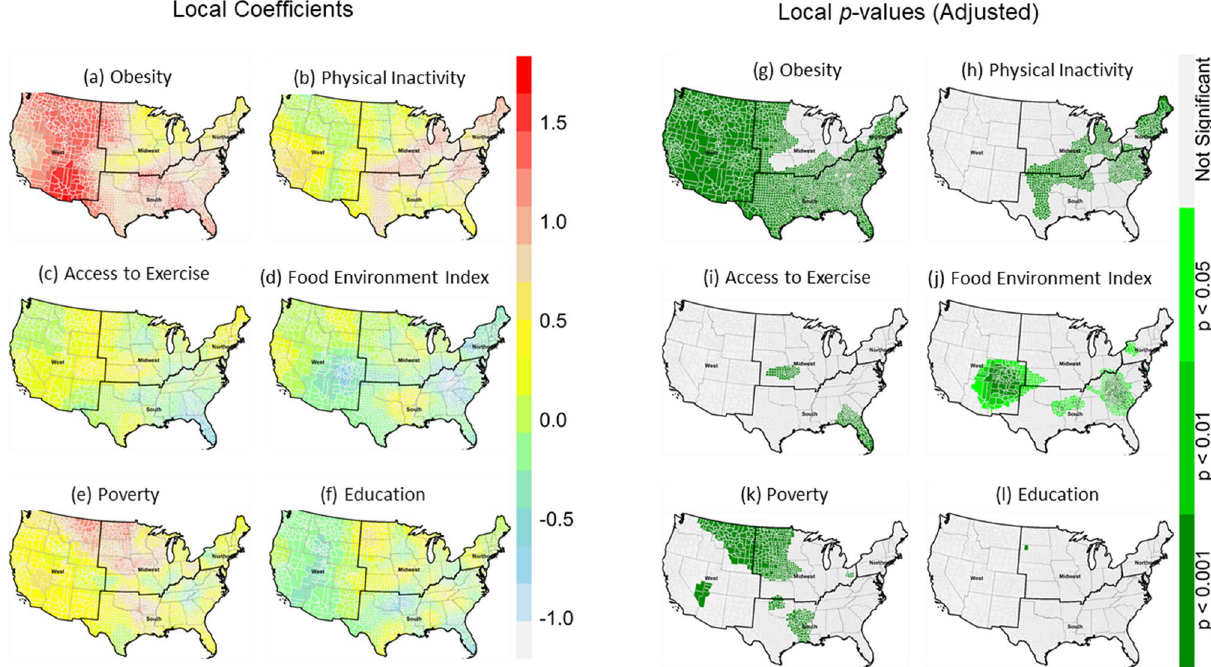
Figure 5. Spatial variation of local coefficients and p -values (adjusted) of geographically weighted OLS (GW-OLS) regression models. ( a – f ) local coefficients of obesity, physical inactivity, access to exercise, food environment index, poverty and education, and ( g – l ) corresponding local p -values of all predictors. Maps were created in the R (version 4.0.0) Statistical Computing Environment 39 .